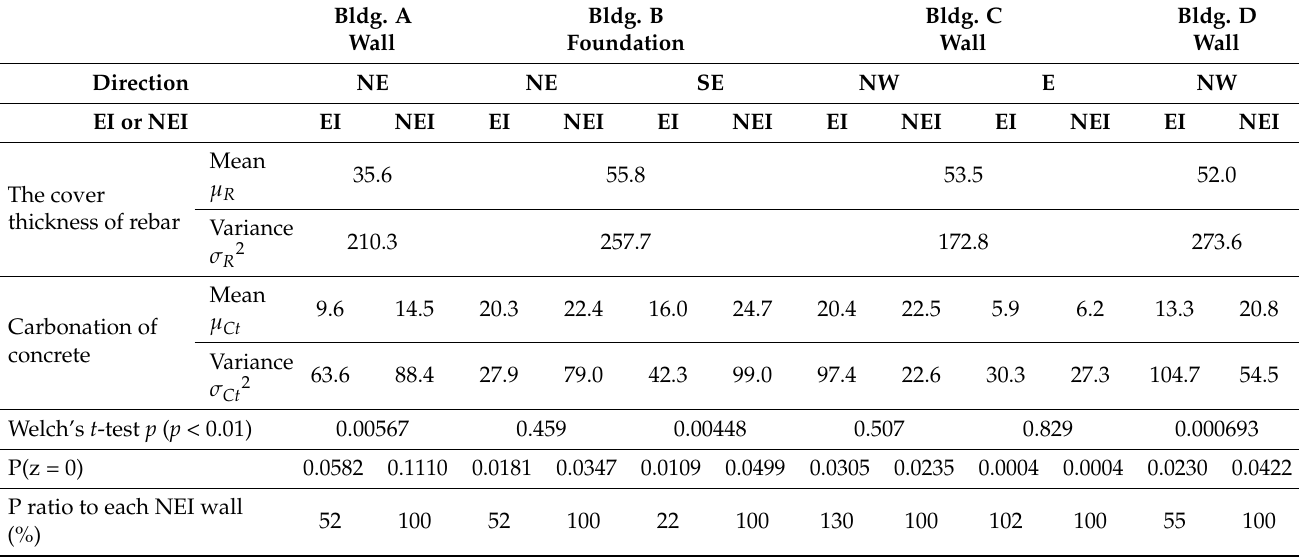
Table 6. Various statistics value, P(z = 0), and the t -test and analysis results for each building. Bldg. A Bldg.